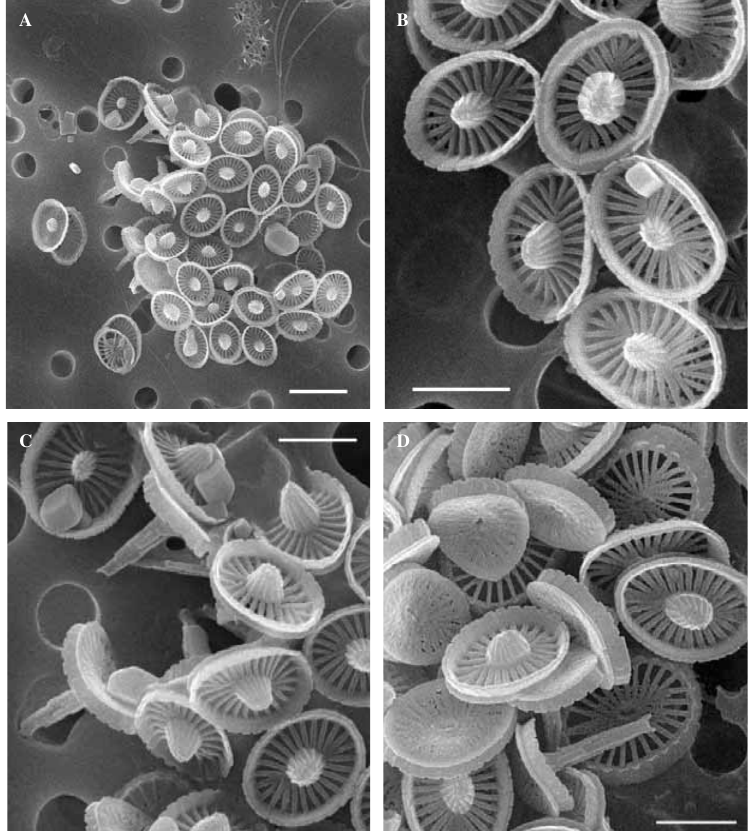
detail of Fig. A showing the varimorphic endothecal body caneoliths; C , detail of Fig. A showing endothecal body cane- oliths with a thick central structure and circum-flagellar caneoliths with a robust and long spine, both with a low wall with characteristic incised upper margin; an exothecal caneolith (upper left) in distal view showing slender laths and a relatively high, distally crenalated wall; D , detail showing body caneoliths with robust wall and proximal flanges, one circum-flagellar caneolith with a long and robust process tipped by two small spines (centre bottom), and some exothe- cal caneoliths with nodes forming a distal flange (right corners) [Meso-96, A5, 70 m]. Sacale bars: A = 2 μm; B, C, D = 1